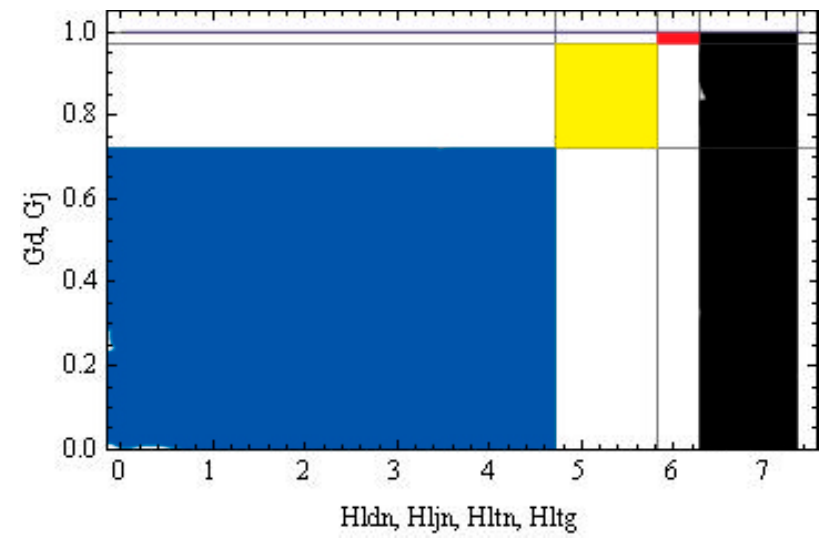
Figure 5. Characterization of a representative interdisciplinary and intertopical orthodox PH. Black area (14.3%) = networking; red area (0.3%) = intradisciplinary and intratopical heterodox; yellow area (4.1%) = intradisciplinary and intertopical orthodox; blue area (53.9%) = interdisciplinary and intertopical orthodox. G d = 0.72, G j = 0.97, H ldn = 4.71, H ljn = 5.74, H ltn = 6.29, H ltg = 7.34. Abbreviations: G d , Gini index for disciplines; G j , Gini index for journals; H , Hirsch indexes; d = discipline, g = gross, j = journal, l = linear, n = net, t = total.